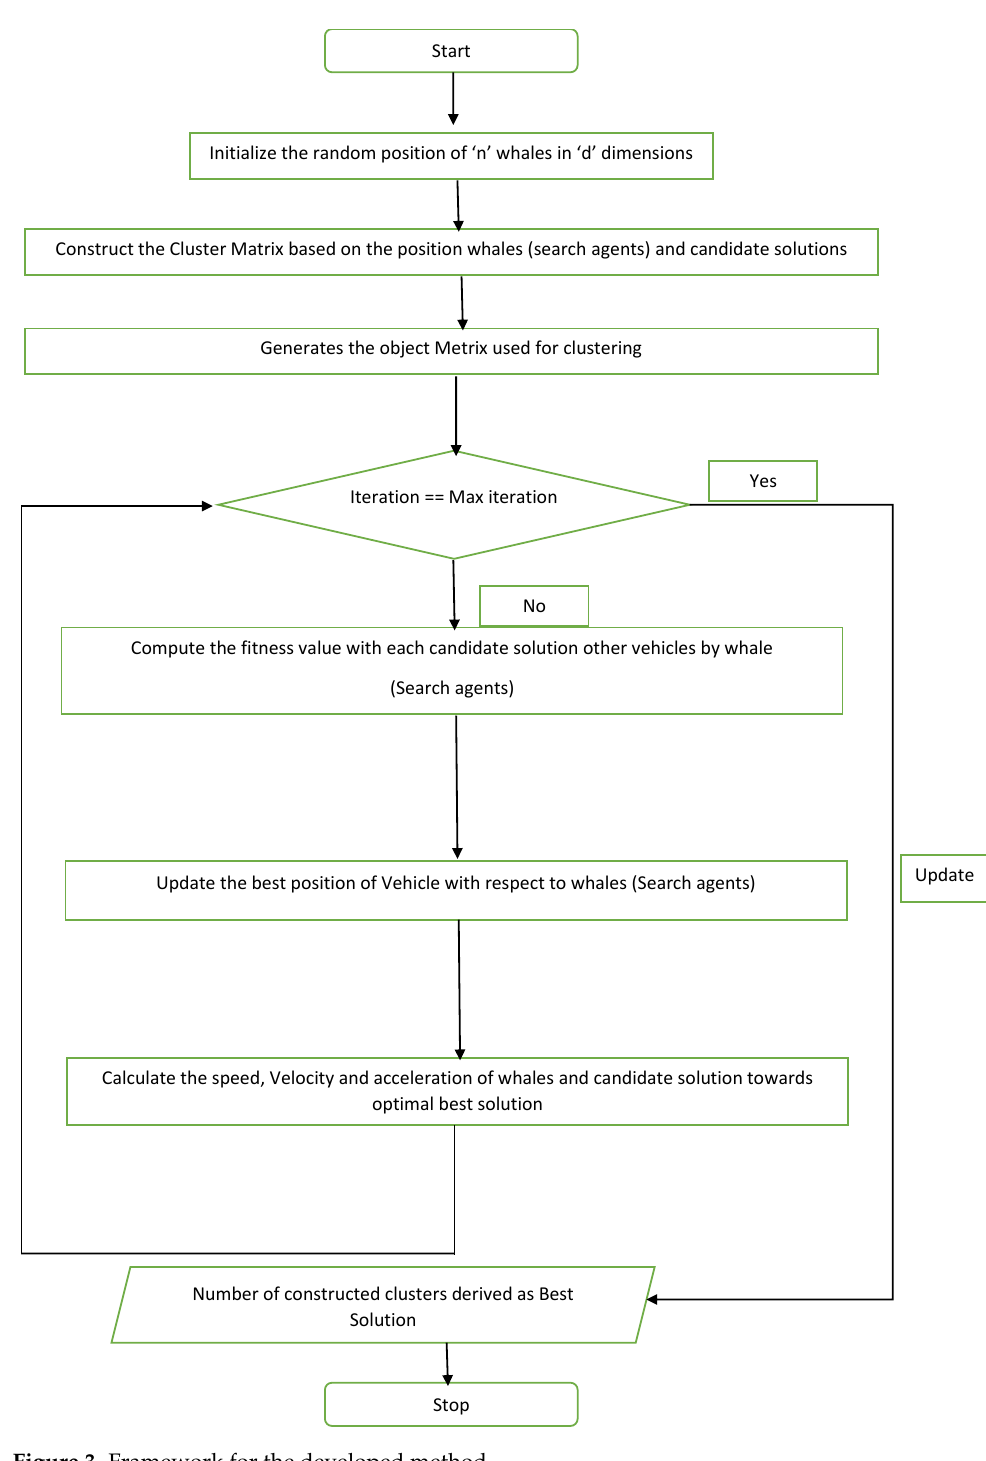
Figure 3. Framework for the developed method.